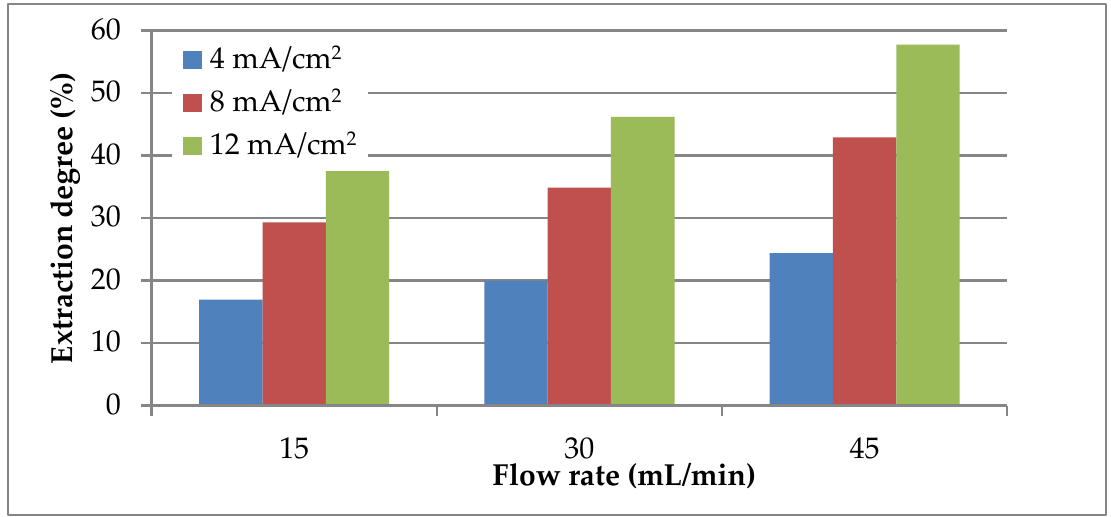
Figure 5. Influence of electrolyte flow rate and current density on lead extraction degree.